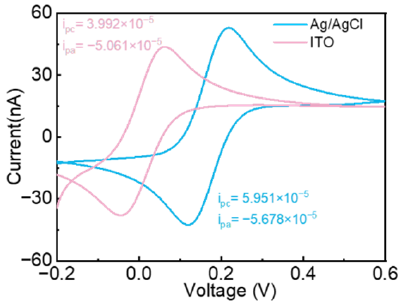
Figure 2. Cyclic voltammetry responses of 5 mM [Fe(CN) 6 ] 3 − /4 solution containing 0.1 M KCl at bare ITO (pink) and Ag/AgCl reference electrode (blue).